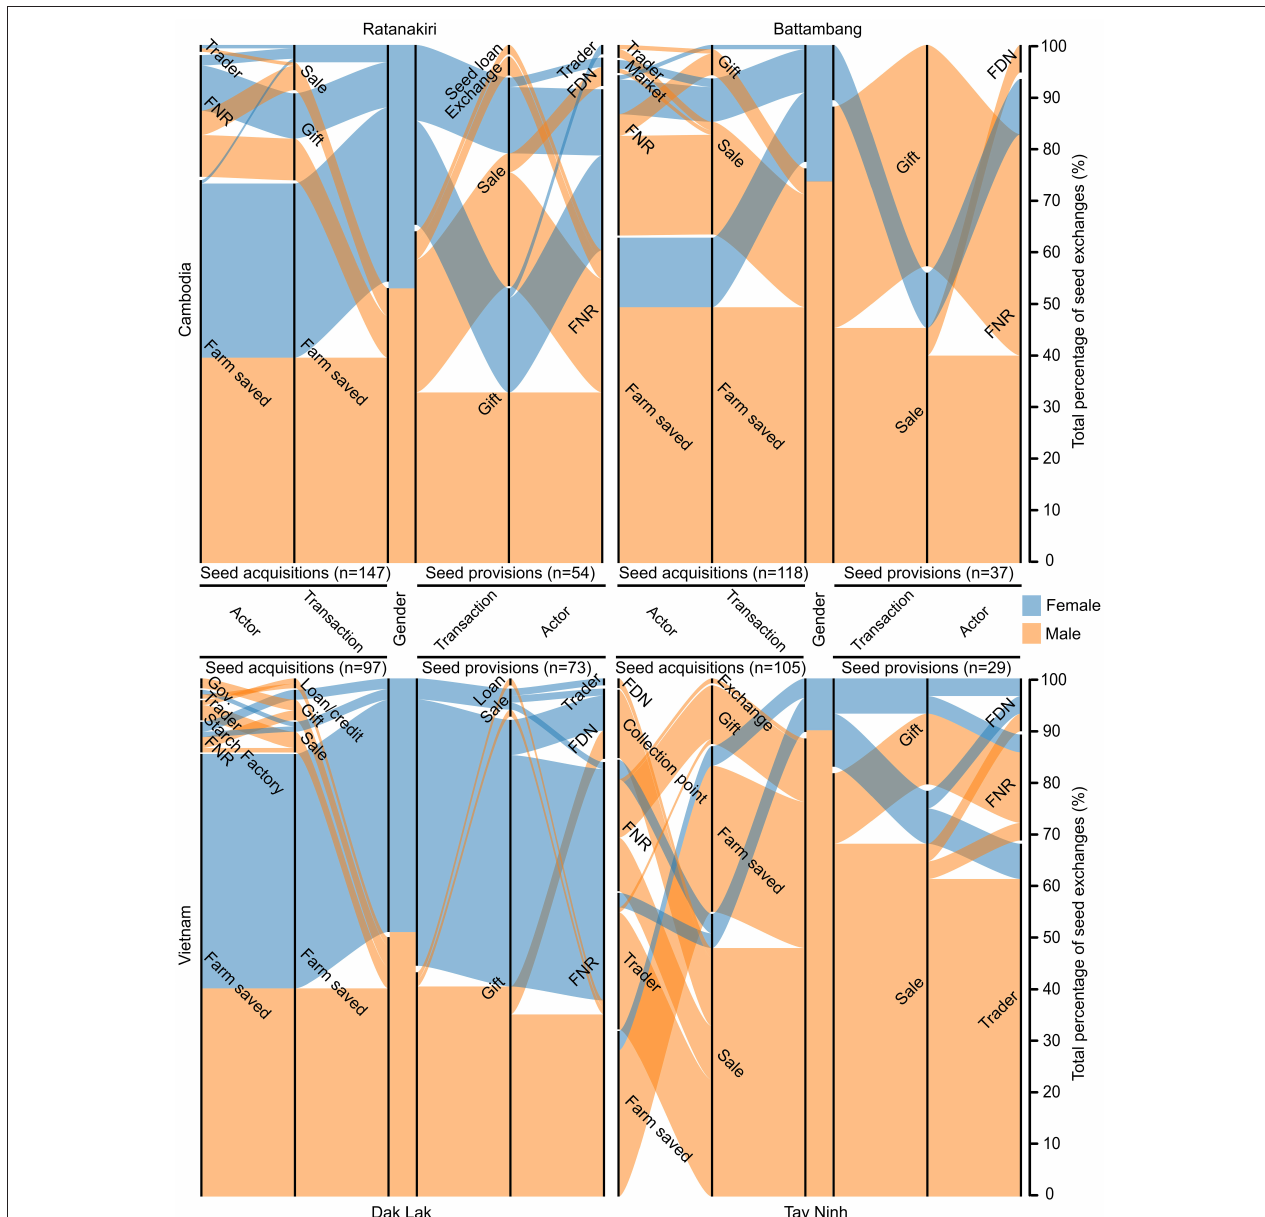
FIGURE 2 | Seed exchange acquisitions, provisions, actors, and mechanisms recorded in the 2016 growing season, at each of four sites in Cambodia and Vietnam, showing relationships between categories of actors and types of transactions. Low production intensity sites are located on the left, with high production intensity sites on the right. Total sample size is 100 for each site except Dak Lak ( n = 94). Black vertical bars represent 100% stacked percentages. “Actor” indicates identified sources and sinks of cassava planting material, with “FNR” indicating “farmer/neighbor/relative,” while “FDN” indicates “farmer I do not know personally.” “Transaction” indicates socioeconomic mechanism of exchange for each acquisition and provision. Gender segments for each of acquisitions and provisions indicate the relative gendered contribution to the total number of transactions. The center columns of each subplot represent the gender proportion of survey respondents at each